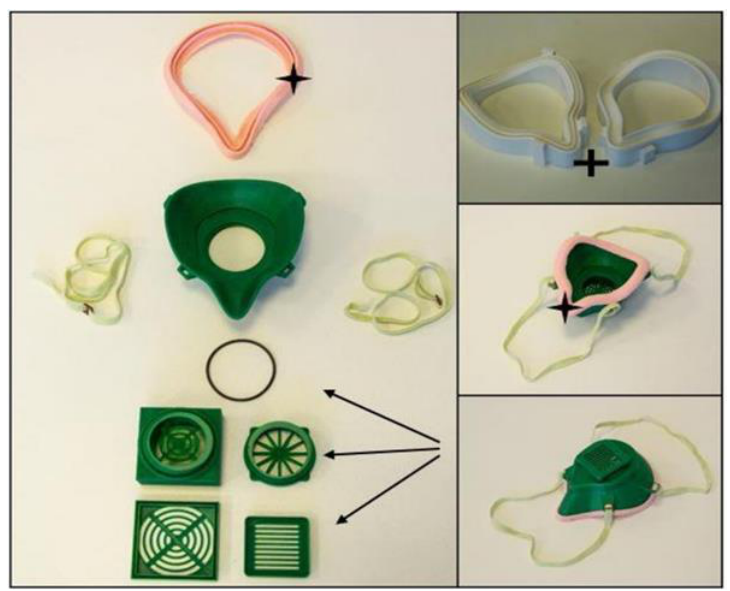
Figure 8. Face Mask V.2.0: The model improvements are marked as follows: interchangeable and modifiable filter holder parts with an O-ring (black arrows). Silicone ring layer for better face-fitting (black star). Mold for the silicone ring, printed from polylactic acid (PLA) with fused filament fabrication (FFF) technology (black cross).